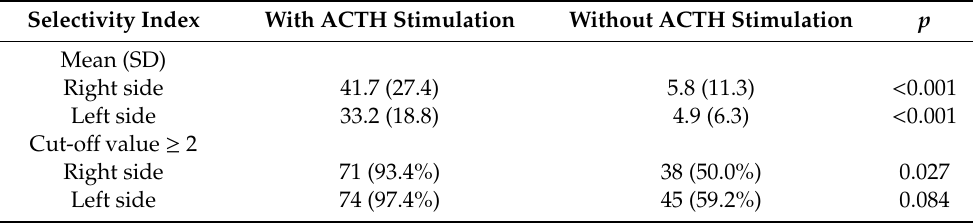
Table 2. Selectivity index results in 76 patients with and without adrenocorticotropic hormone (ACTH) stimulation.